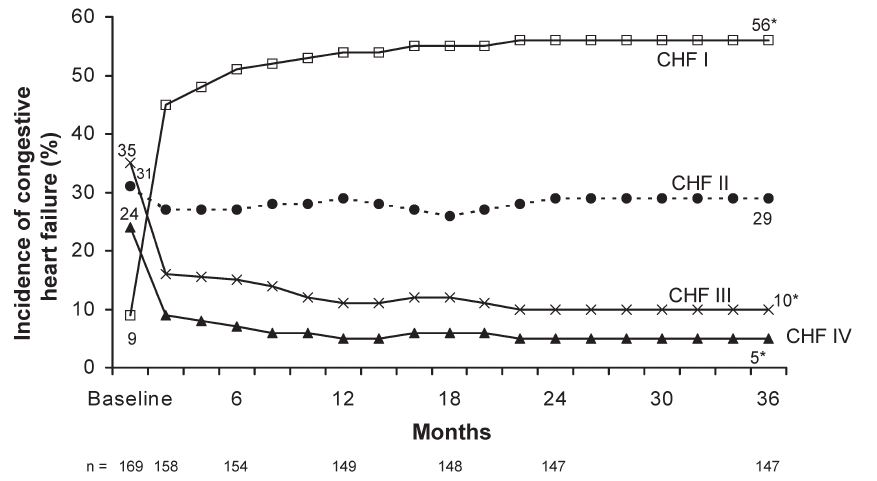
Figure 3 - Incidence of congestive heart failure after surgery according to functional class (New York Heart Association classification). * p , 0.01 vs.